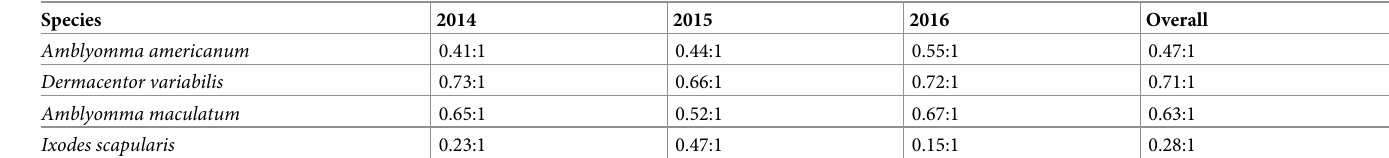
Table 2. Male:Female ratios of tick species collected seasonally from sites located near Pittsburg, Kansas between years 2014–2016. Species